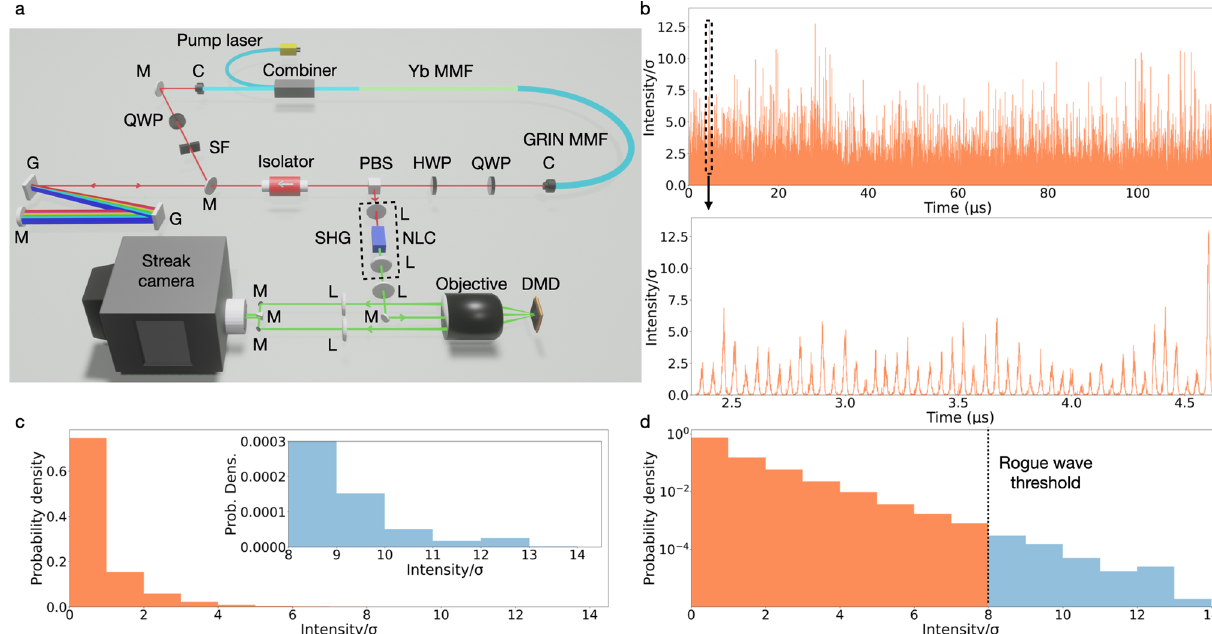
Fig. 1 Experimental setup and temporal measurements. a Schematic of the setup including the laser cavity, second-harmonic generation, and CUP units. Yb MMF Ytterbium-doped multimode fi ber, GRIN MMF graded-index multimode fi ber, C collimator, G diffraction grating, QWP quarter-wave plate, HWP half-wave plate, PBS polarizing beamsplitter, M mirror, SF spatial fi lter, L lens, SHG second-harmonic generation, NLC nonlinear crystal, DMD digital micromirror device. b Temporal intensity pro fi le normalized to the standard deviation of intensity of the time trace ( σ ). c Histogram of the temporal intensity pro fi le shown as normalized probability density. d The same histogram on semi-logarithmic